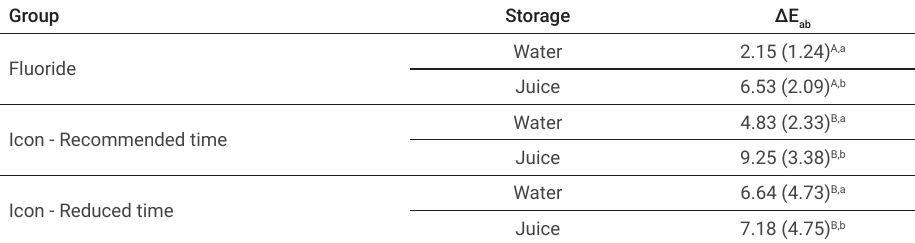
Table 2. Mean ∆E and standard deviation for treatment groups and storage methods. ab